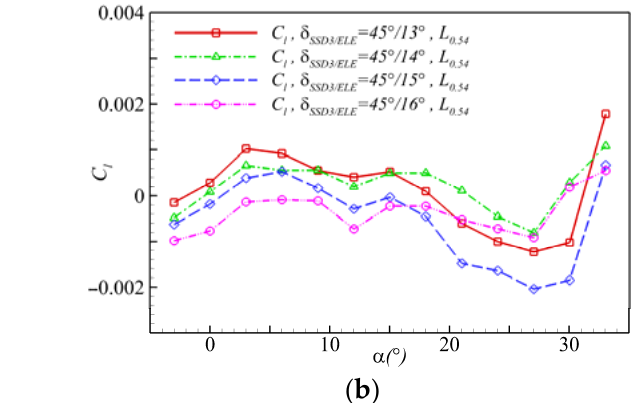
Figure 18. Variation of yawing and rolling moments with δ deflection of elevon (at δ SSD3 = 45°) at different α . Figure 19 shows the three ‐ axis moment characteristics of the five groups of FCRs. The yaw moments provided by the FCRs composed of five types of collocating deflection an ‐ gles are considerably greater than the rolling moments at small and medium angles of attack, while the difference in the pitching moment between the configuration with the five different FCRs and the baseline configuration is small. ( a ) ( b ) Figure 19. Control characteristics of the selected FCRs, Ma = 0.2, Re = 3.98 × 10 7 : ( a ) Pitching moment; ( b ) Yawing and rolling moments. The results of this section show that the FCR proposed herein can satisfy the require ‐ ments of directional stability and control of lateral maneuvering flight for a low ‐ aspect